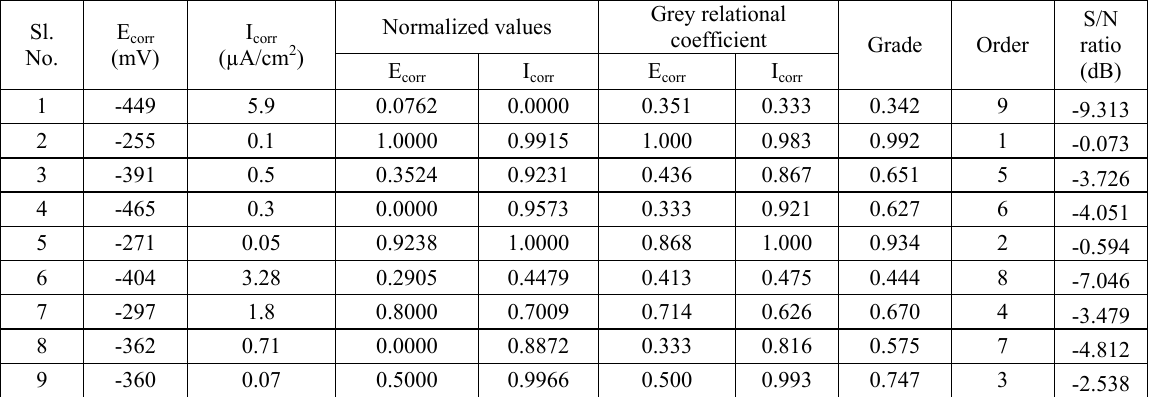
Table 3. Results of corrosion tests and grey relational analysis